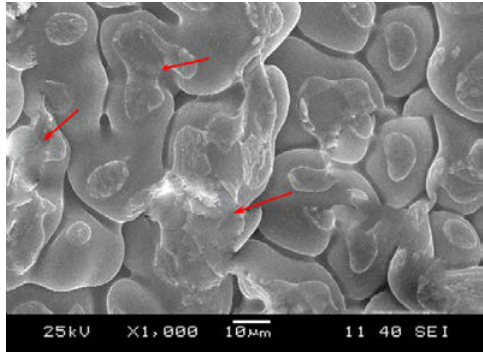
Figure 8. Enlarged view of area A in Figure 6.